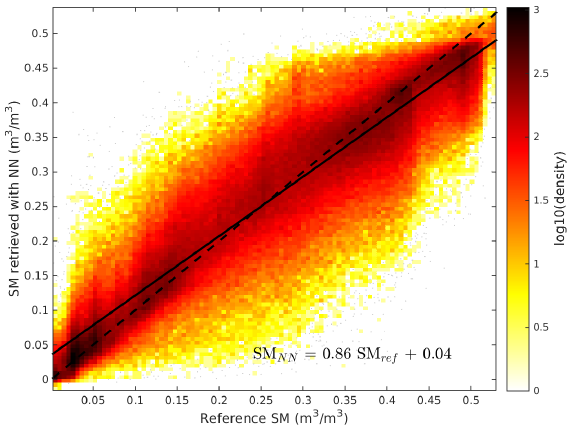
Figure 3. Scatter plot of the SM estimated from the NN for the test sub set with respect to the reference ECMWF SM 1 data